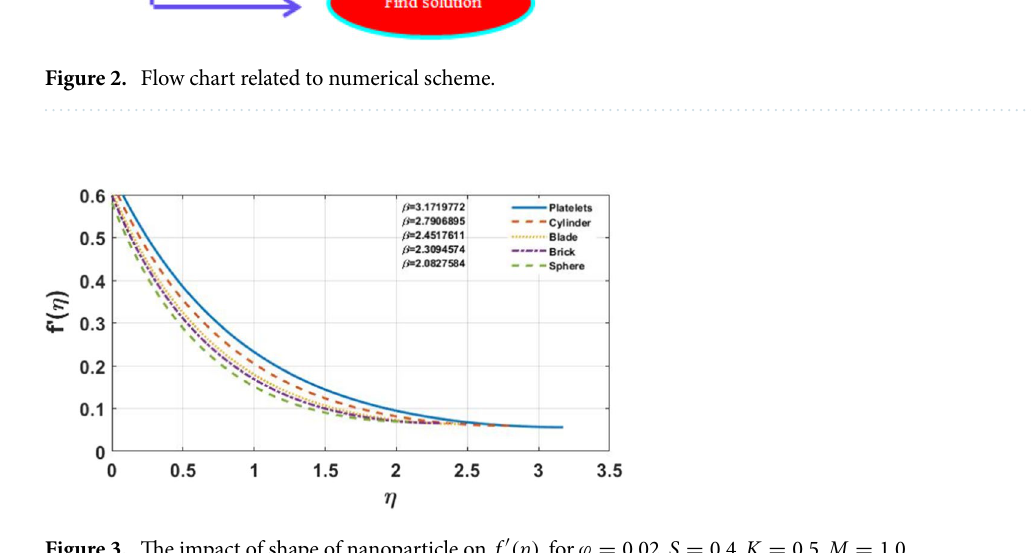
Figure 3. The impact of shape of nanoparticle on f ′ (η) , for ϕ